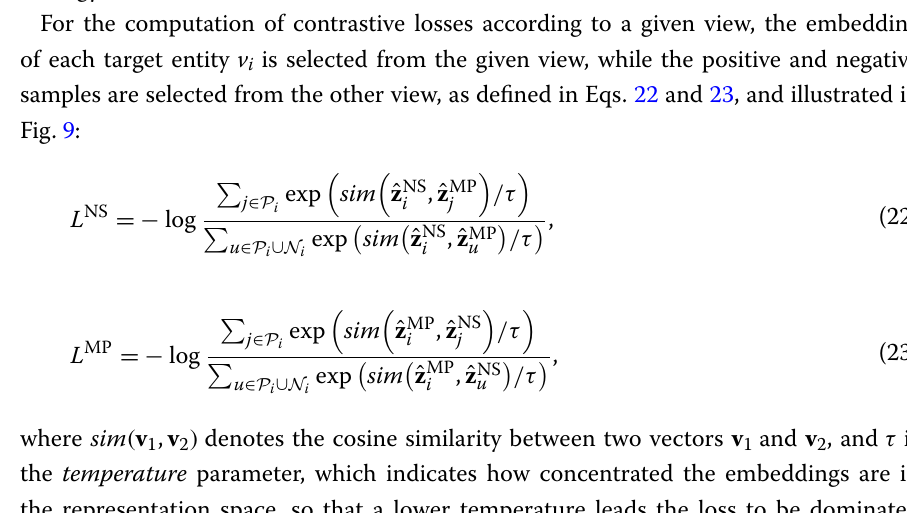
) and negative ( ) samples are under the network + −